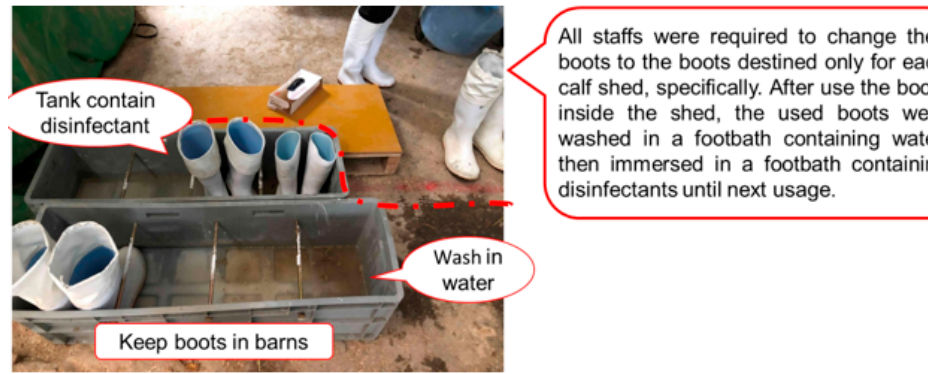
Figure 1. Biosecurity measures strengthened through boot hygiene at Farm A. Disinfectants: QAC (Rontect ® , Scientific Feed Laboratory Co., Ltd., Tokyo, Japan), diluted 1:500 with tap water and added FdCa(OH) 2 powder (Fine Co., Ltd., Tokyo, Japan) at the final concentration of 0.17% at the exit of each calf